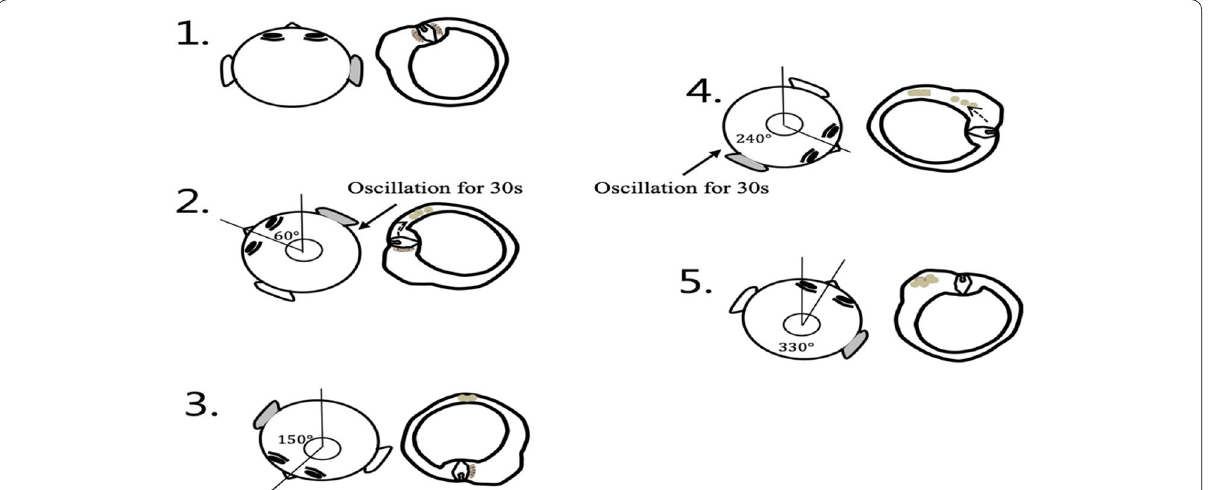
Fig. 4 Schematic of the modified cupulolith repositioning maneuver’s 1–5 positions in the right horizontal canal light